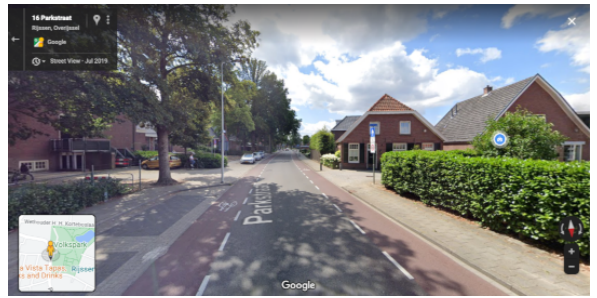
Figure 3. Rijssen Google Street View sample